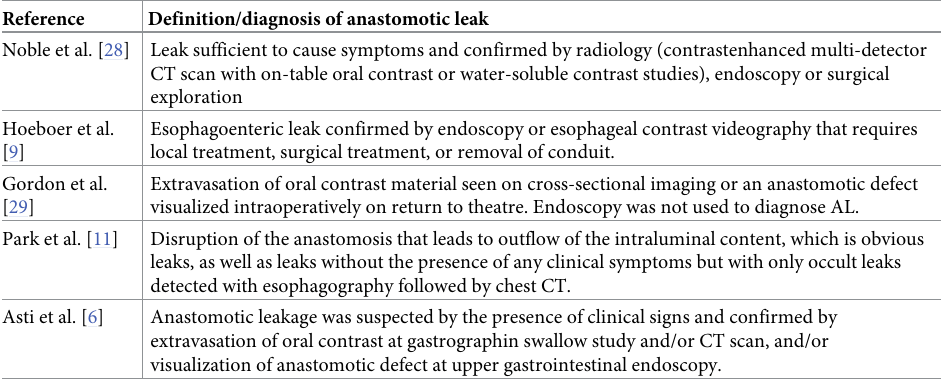
Table 1. Definition of anastomotic